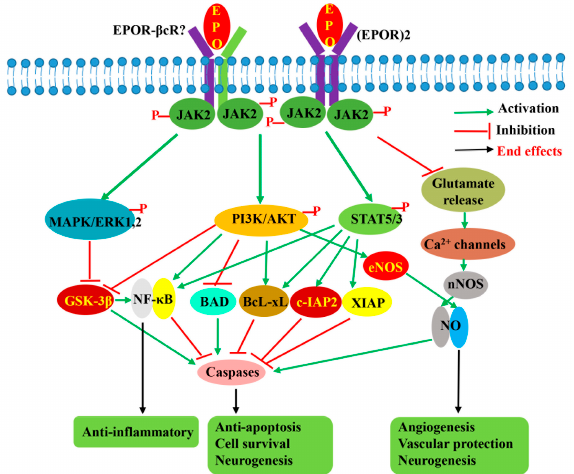
Figure 3. EPO-induced signaling pathways involved in its neuroprotective effects. EPO by binding to either homodimeric (EPOR) 2 receptor or another possible heterodimeric receptor EPOR- β cR activates JAK2 by phosphorylation, followed by activation of downstream STAT5, PI3K/AKT, and MAPK signaling pathways, as well as regulation of voltage-gated Ca 2+ channel. The activation of these three signaling pathways results in the activation of anti-apoptotic and anti-inflammatory pathways benefiting cell survival while promoting angiogenesis and neurogenesis. The suppression of glutamate release benefits cell survival and inhibits apoptosis through the regulation of voltage- gated calcium ion channels to lower glutamate